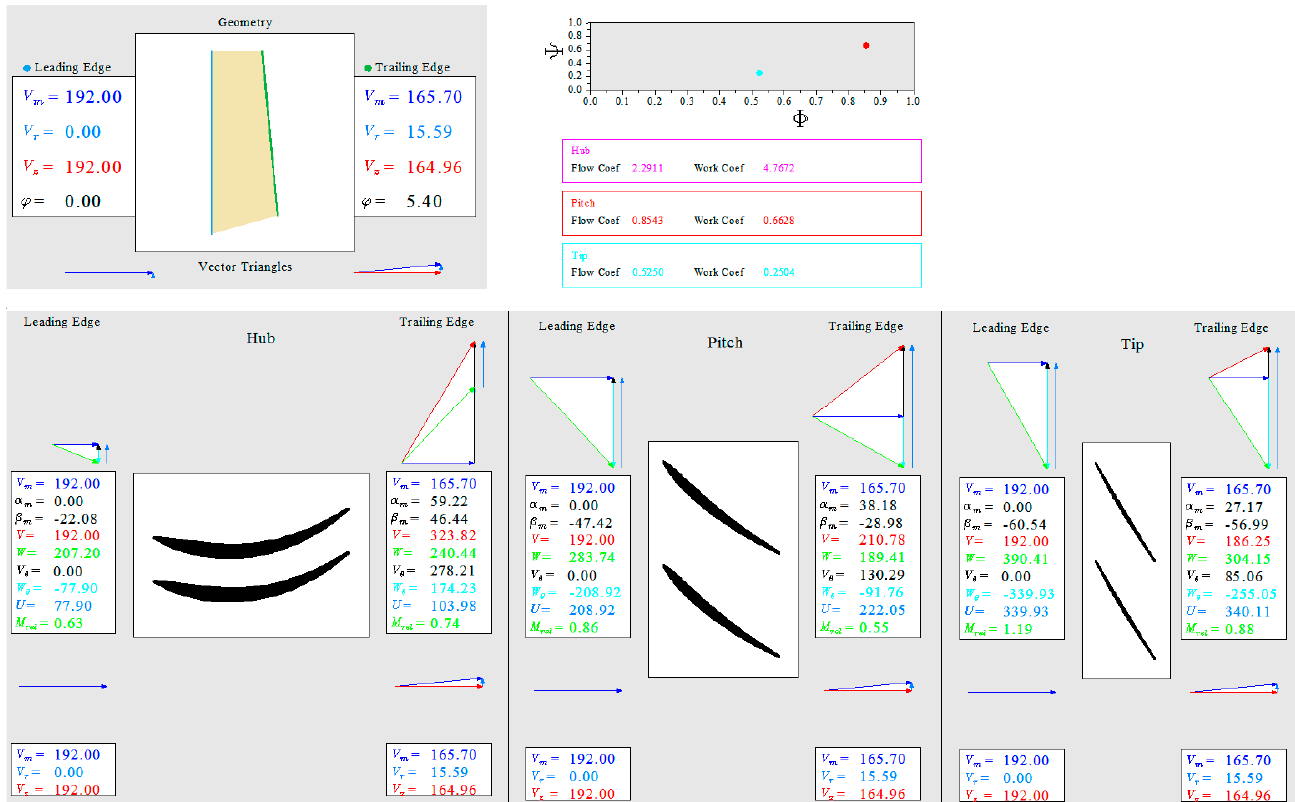
Figure 4. Velocity triangles for a turbofan rotor example at the hub, mid, and tip using the T-Axi Blade tool.